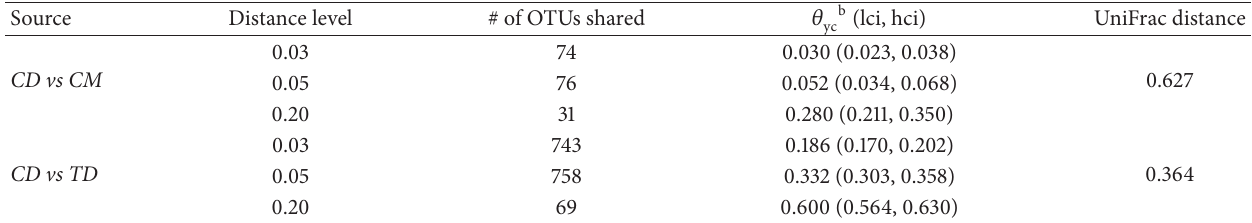
Table 3: Comparisons of intestinal bacterial diversity between chickens and